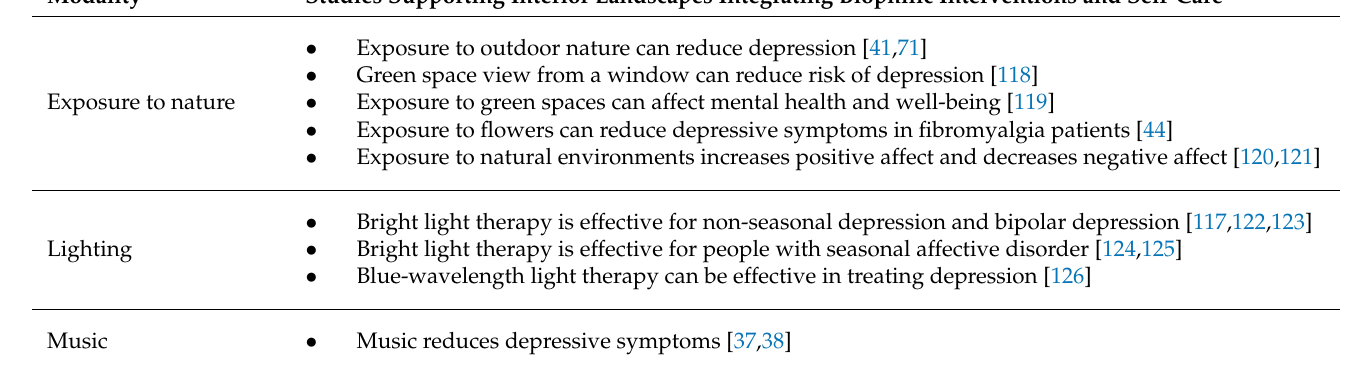
Table 3. Clinical evidence on incorporating nature exposure and self-care modalities into therapeutic interior environments for people with